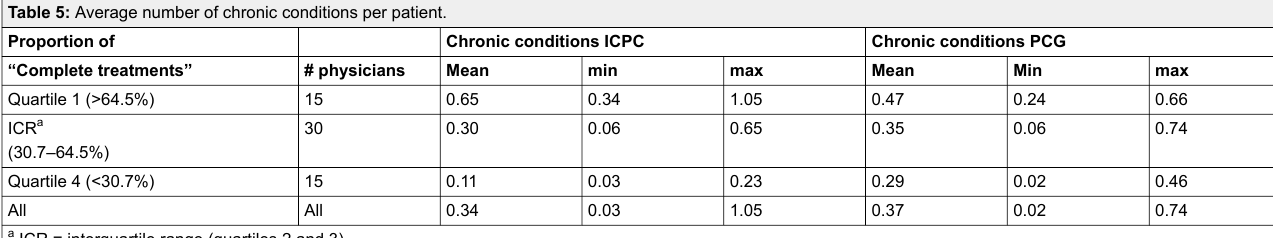
Table 5: Average number of chronic conditions per patient. Proportion